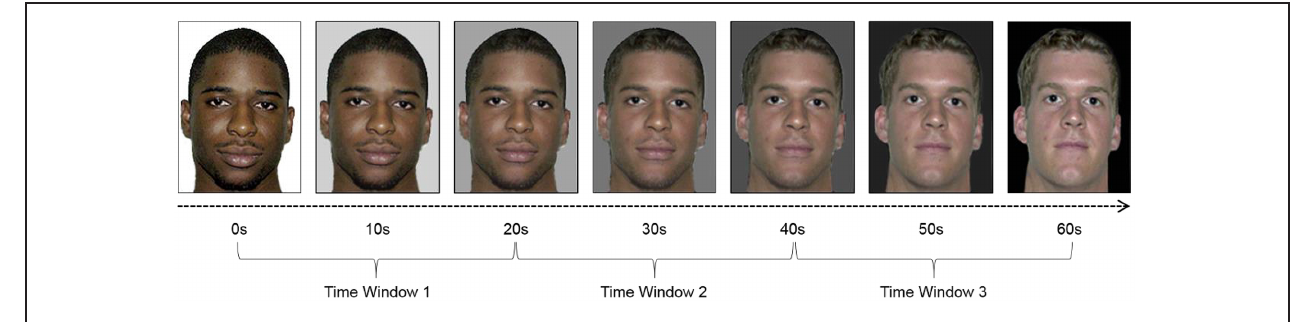
FIGURE 1 | Sample images taken from one of the 60-s videos of faces morphing from Black to White used in Study 1. Faces changed from Black at 0 s to White at 60 s; Time windows used for analysis are as indicated.